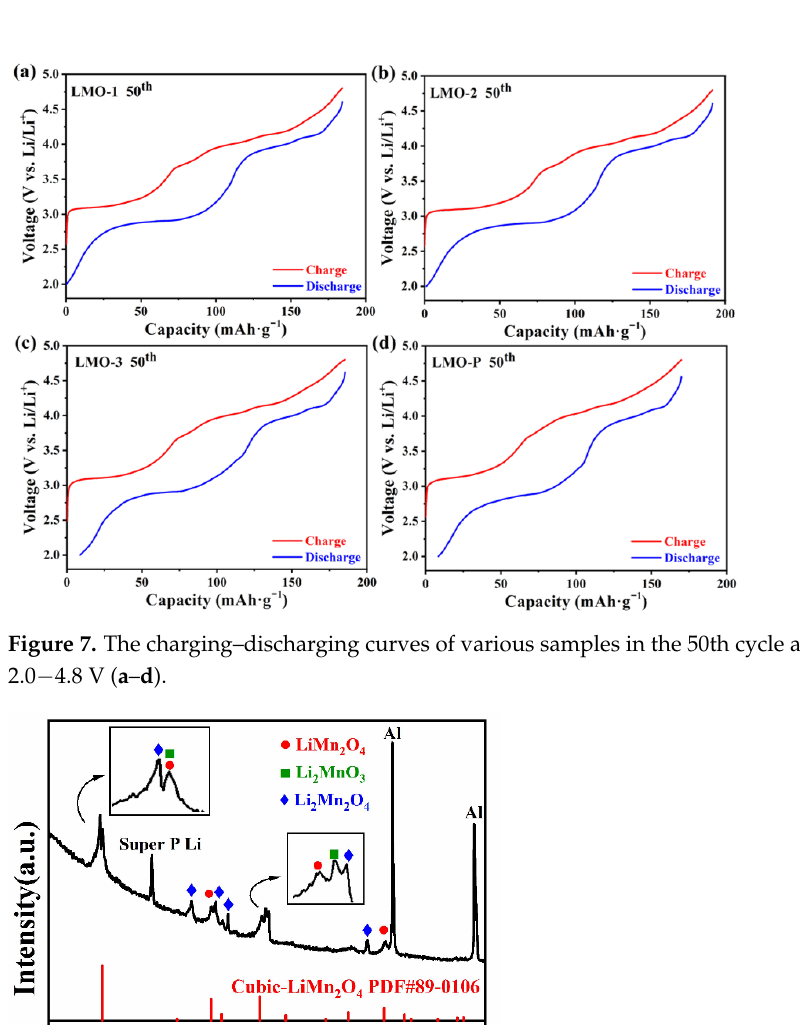
Figure 8. The XRD pattern of the discharged LMO-2 cathode disk after 15